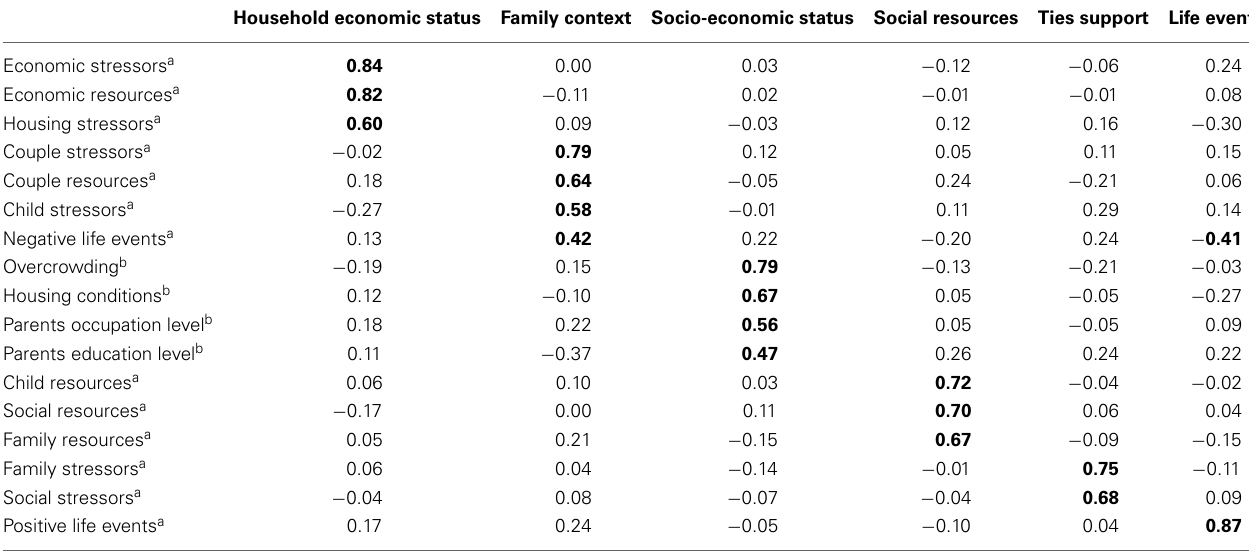
Table 5 | PCA results depicting variables associated with socioeconomic status and level of stressors and resources in the SIP. Household economic status Family context Socio-economic status Social resources Ties support Life